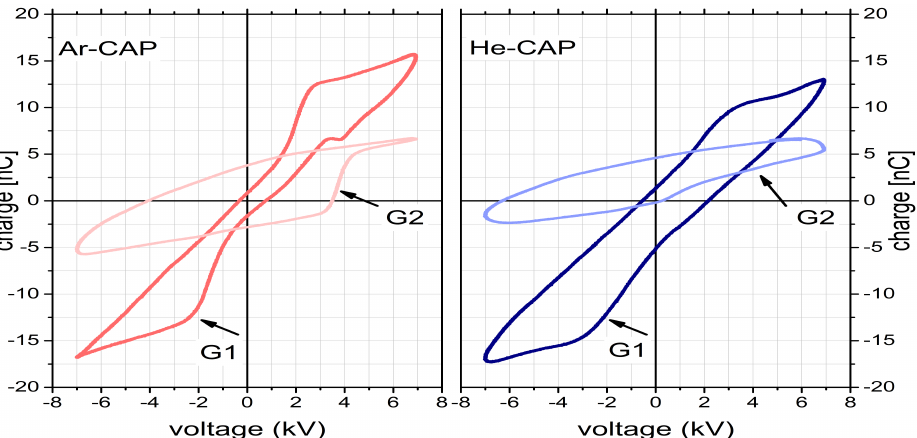
Figure 5. Charge-voltage plot for device operation in argon ( left ) and helium ( right ), each for an applied voltage of 14 kV pp and a quartz plate at 5 mm